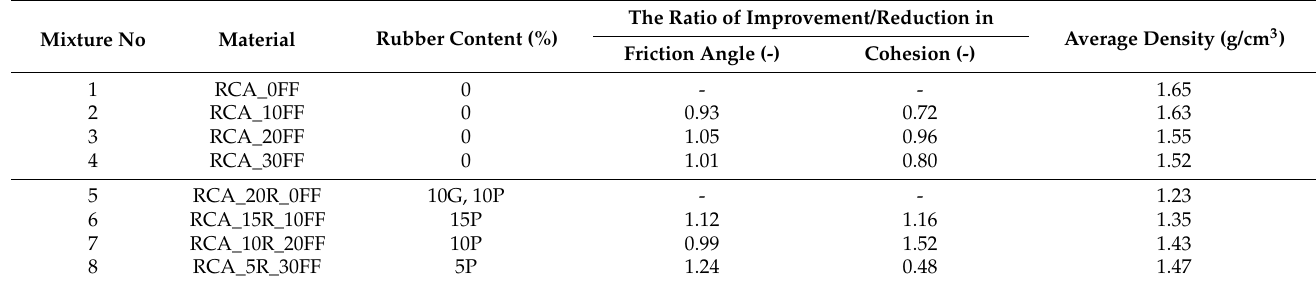
Table 8. Variations of strength parameters and results of density for studied